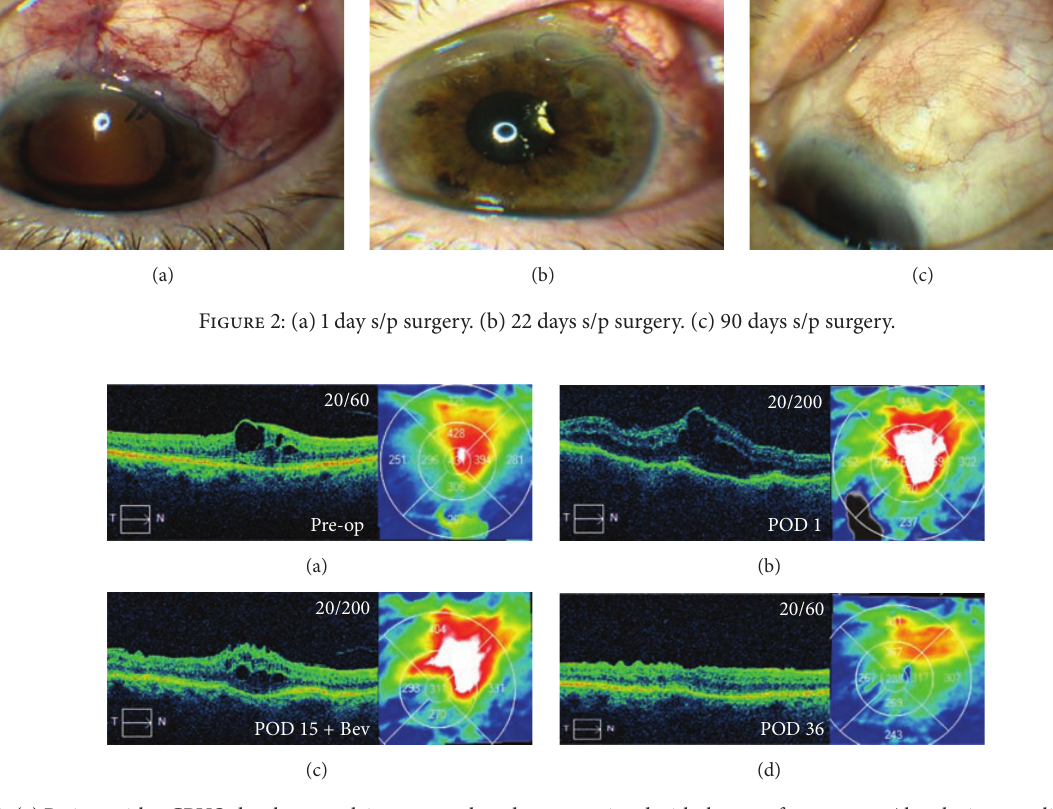
Figure 3: (a) Patient with a CRVO develops recalcitrant macular edema associated with the use of travoprost. Also she is struggling to achieve her target IOP despite maximal medical management and elects to proceed with Ahmed Valve surgery. Pre-op VA is 20/60. (b) POD 1, IOP reducedto0 mmHgoffallantiglaucomamedicationsbutplacedontopicalsteroiddifluprednate(Durezol,Alcon)atQIDforthepostoperative edema. POD 1 VA is 20/200. (c) POD 15 VA is 20/200 and, given the residual edema, intravitreal bevacizumab injection is given. (d) POD